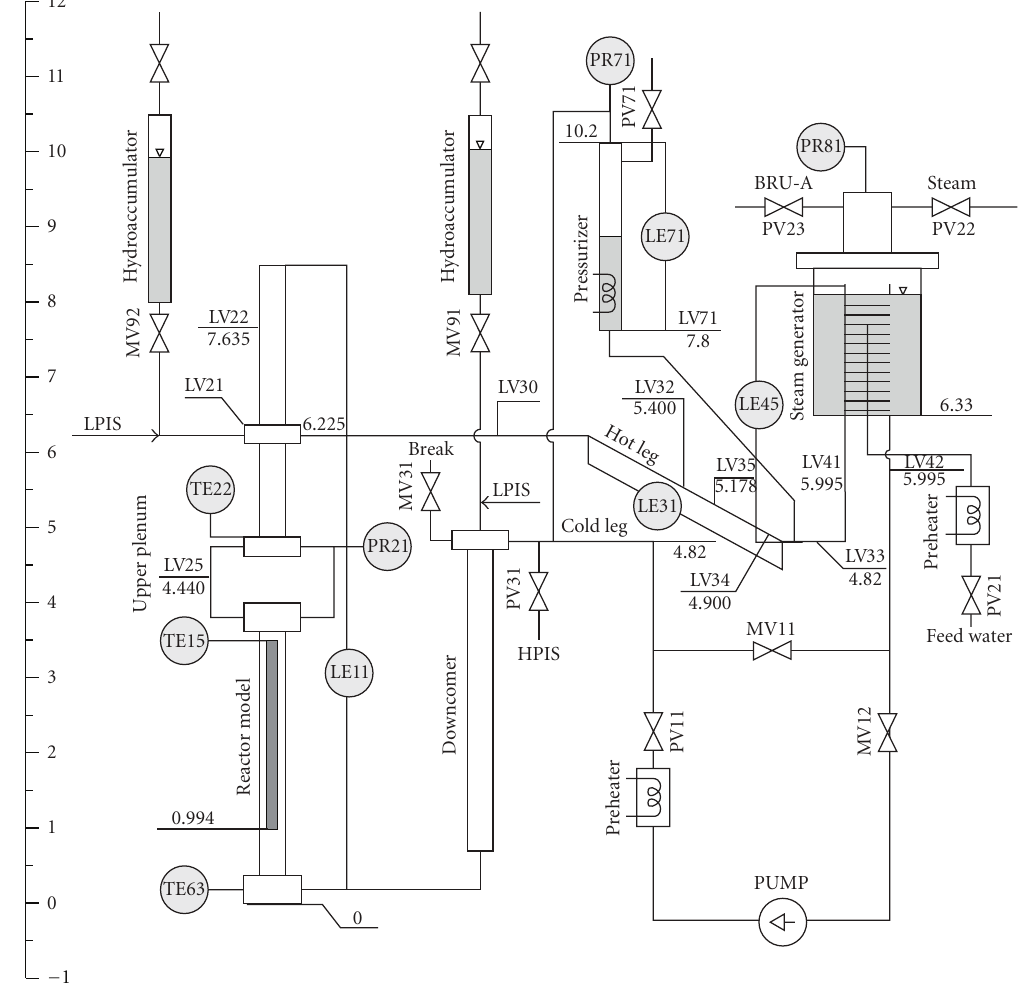
Figure 5: Scheme of PMK-2